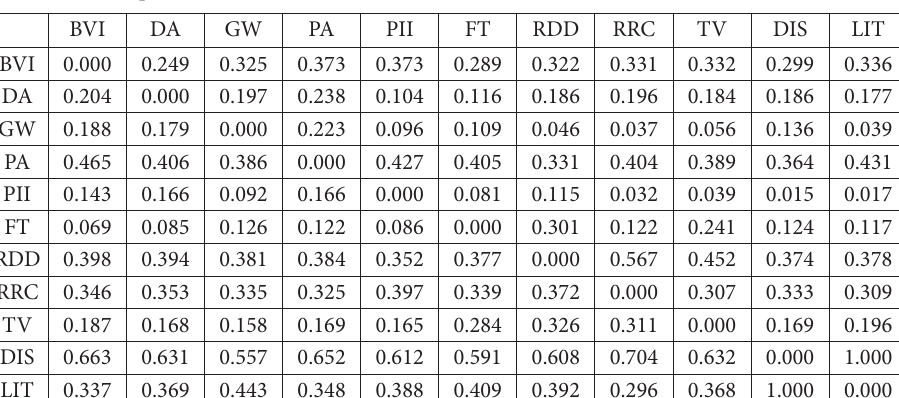
Table 3. Inner dependence matrix of 11